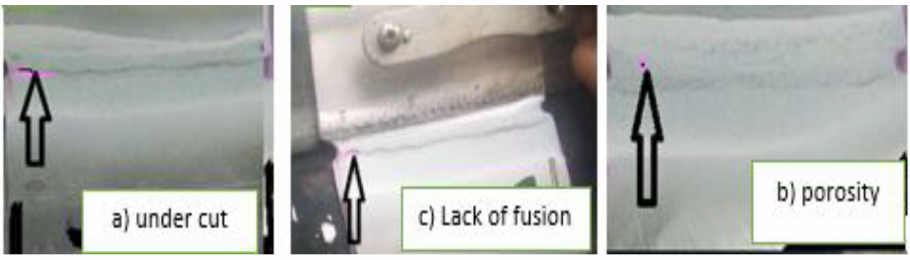
Figure 8. Defects in dissimilar weld metals: ( a ) sample no. 1, ( b ) sample no. 2, and ( c ) sample no.